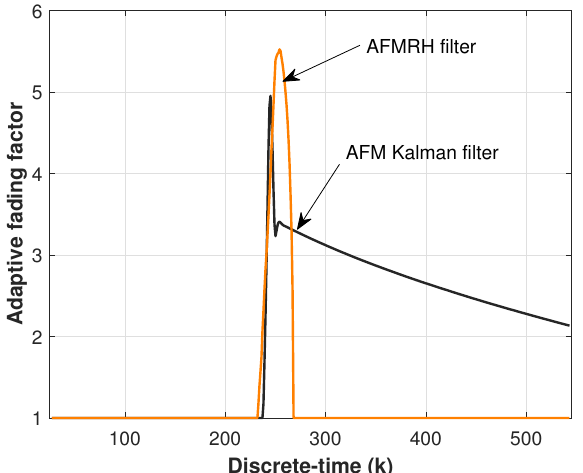
Figure 3. Changes in adaptive fading factors of the proposed AFMRH filter and AFM Kalman filter.